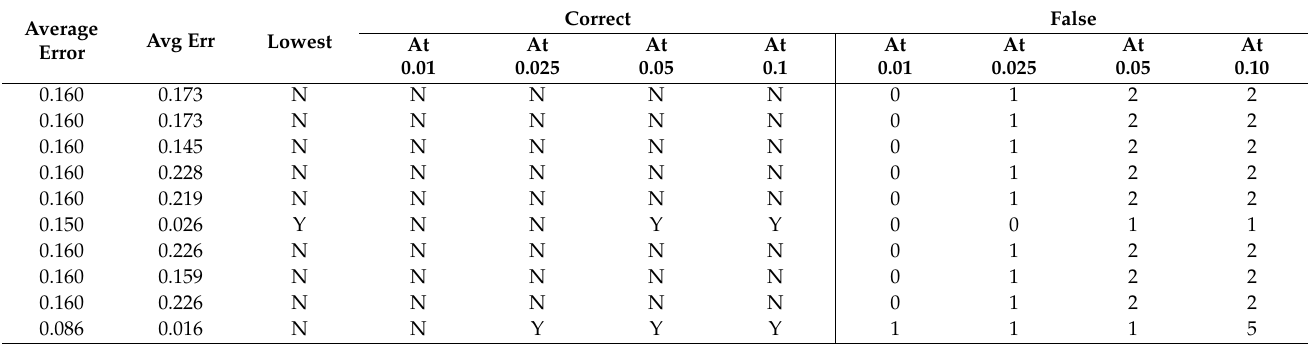
Table A61. Set 1, trials 31–40 summary data (all 0.5 PR values).